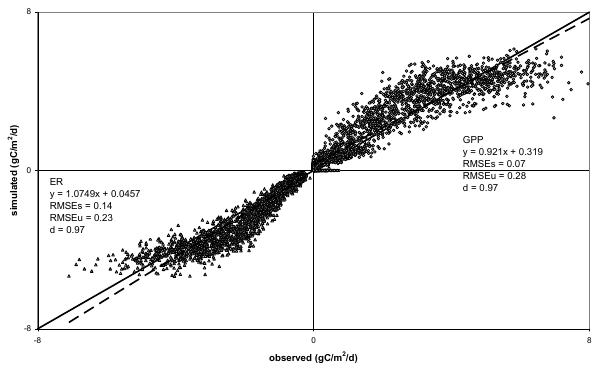
Fig. 2. The scatter plot of observed and simulated daily GPP and ER for 1999–2006. The solid black line indicates the 1:1 line and the dashed line is the best fit relationship between the observations and the simulated GPP and ER.